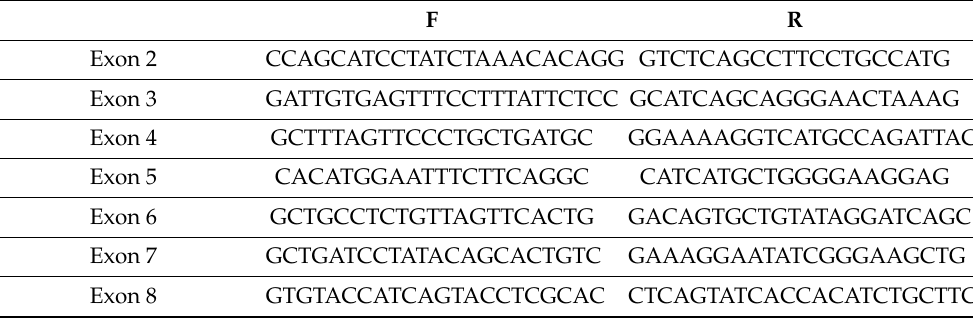
Table 2. Primer sequences of CTSK gene exons.